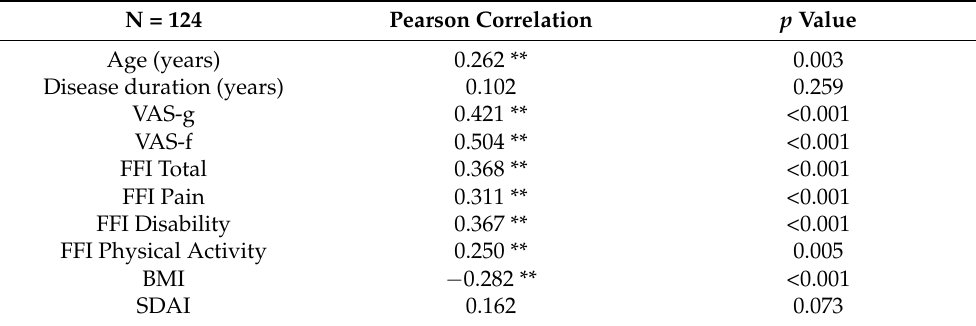
SDAI 0.162 0.073 VAS-g: Visual Analogue Scale general pain; VAS-f: Visual Analogue Scale foot pain; FFI: Foot Function Index; BMI: Body Mass Index; SDAI: Simplified Disease Activity Index.* The correlation is significant at the 0.05 level (bilateral). ** The correlation is significant at the 0.01 level